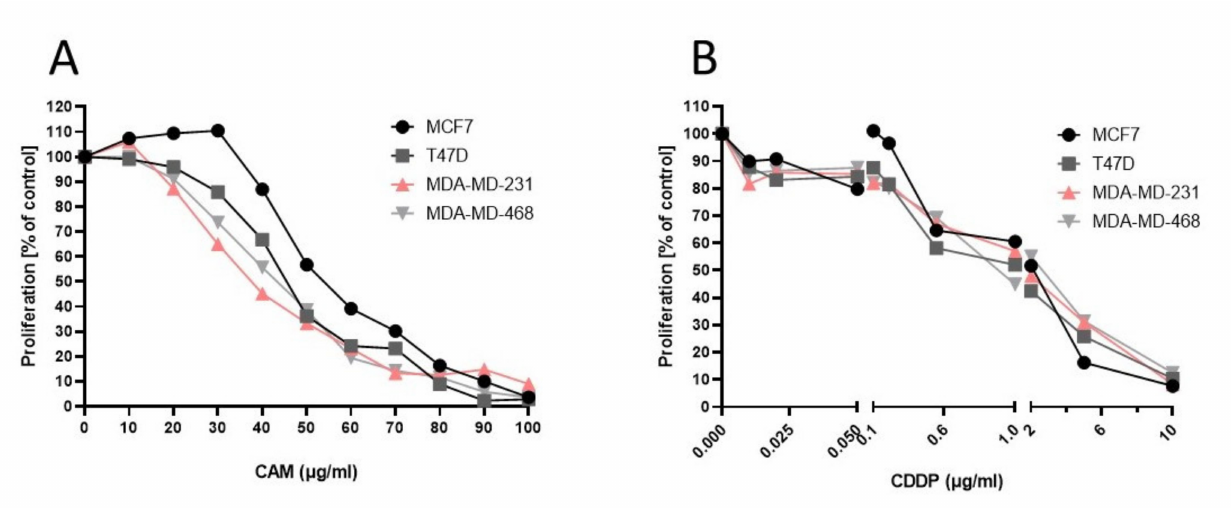
Figure 1. The antiproliferative effect of CAM and CDDP used separately against BC cell lines ( A , B ). Inhibition of cell proliferation was measured by the MTT assay after 96 h of treatment with various concentrations of active agent. All results were analyzed using GraphPad Prism 9.0 software (ordinary one-way ANOVA; Dunnett’s multiple comparisons test). Statistical differences were considered relevant at p < 0.05 (* p < 0.05, ** p < 0.01, *** p < 0.001 versus the control). Data are expressed as mean ± standard deviation of the mean ( ± SD). Table 1. Anti-proliferative effects of CDDP and CAM administered separately in BC cell lines